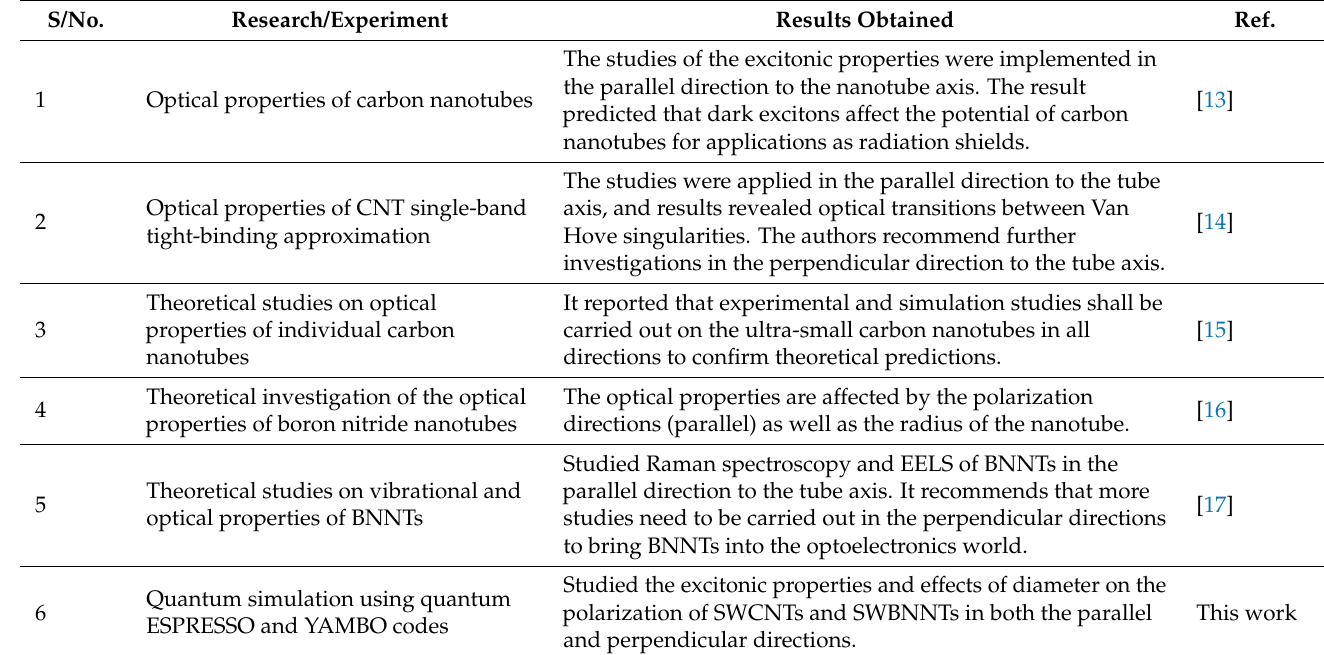
Table 1. Reported studies on the optical properties of